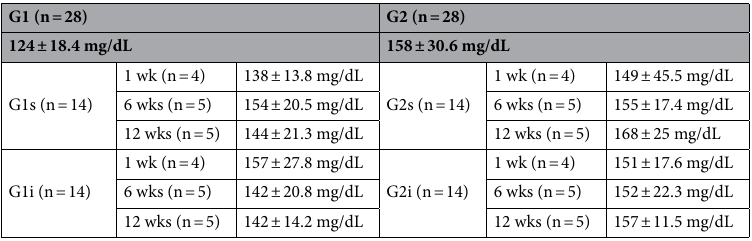
Table 1. Distribution of animals per experimental groups. Mean values and standard deviation for glycemia at the intraperitoneal glucose tolerance test 2 h timepoint, expressed as milligrams per deciliter (mg/dL), for each experimental group of normal (G1) and glucose intolerant (G2) animals, either kept in silence (s) or exposed to high-intensity infrasound